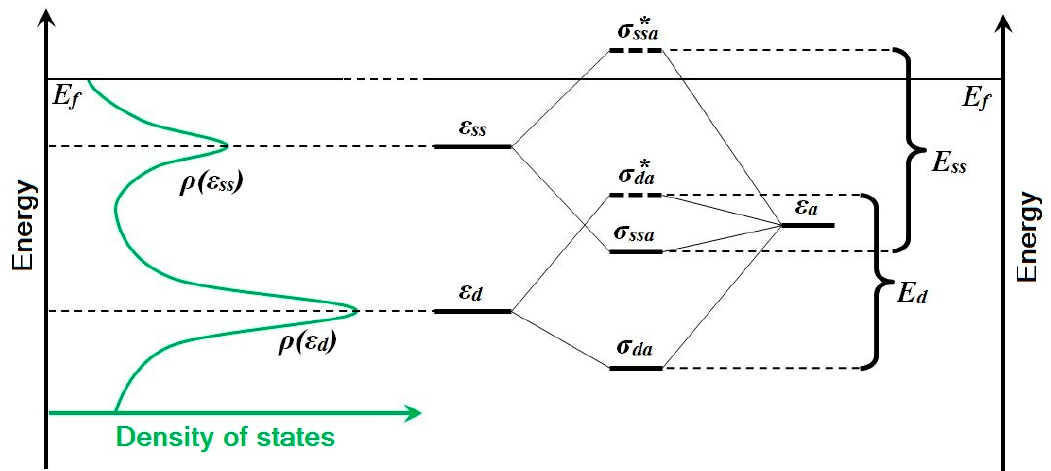
Figure 5. Correlation diagram illustrating the difference in position of antibonding orbitals formed due to the interaction of adatom with surface states and d- band states.